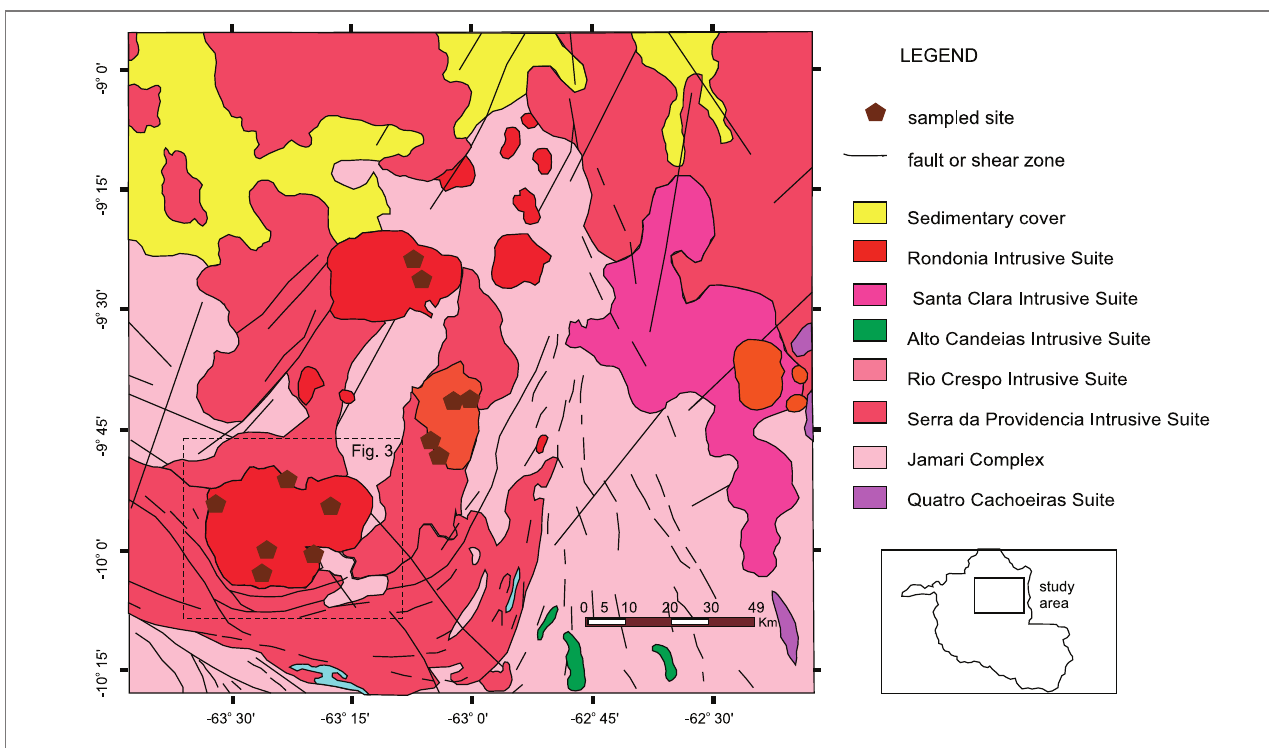
FIGURE 2 – Geologic map of the Rondônia Tin Province showing the points of U-Pb and Lu-Hf isotopic analysis (black stars). Massangana Massif: (A) Massangana magmatic phase, (B) São Domingos, (C) Bom Jardim and Taboca magmatic phases. Adapted and modified from < http://geosgb.cprm.gov.br/> and Romanini (1982). Analyzed samples: 1) BD-MA-14, 2) BD-MA-27, 3) BD-MA-08; 4) BD-MA-21; 5) BD- MA-32; 6) BD-SC-45; 7) BD-SC-46; 8) CN-MG-10; 9) CN-MG-12; 10) BD-CT-02 and 11)